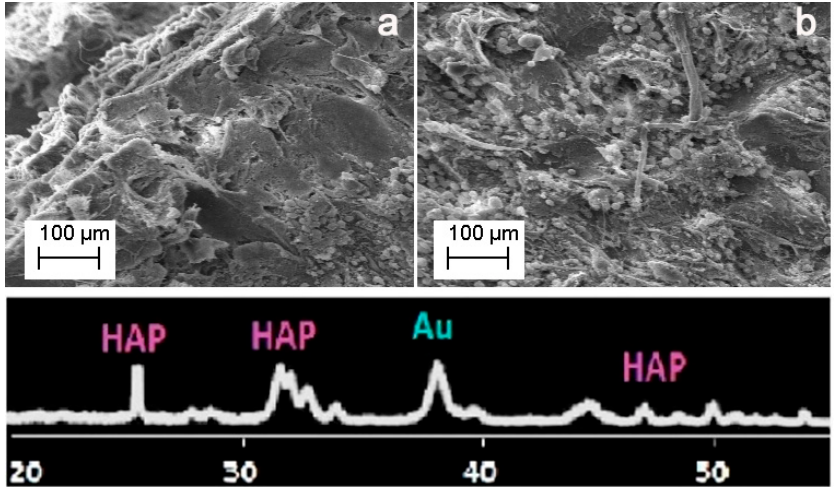
Figure 4. Representative SEM images of AuNR_MgHA scaffolds without ( a ) and with cells ( b ), and XRD analysis at day 7. Magnification 200×.